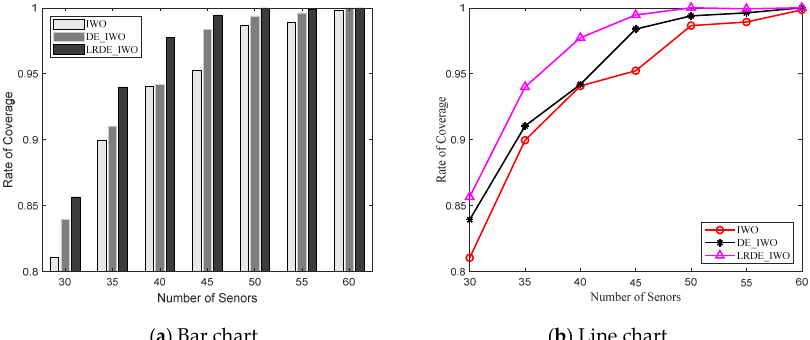
Figure 5. Bar chart and line chart of coverage varying with the number of nodes.